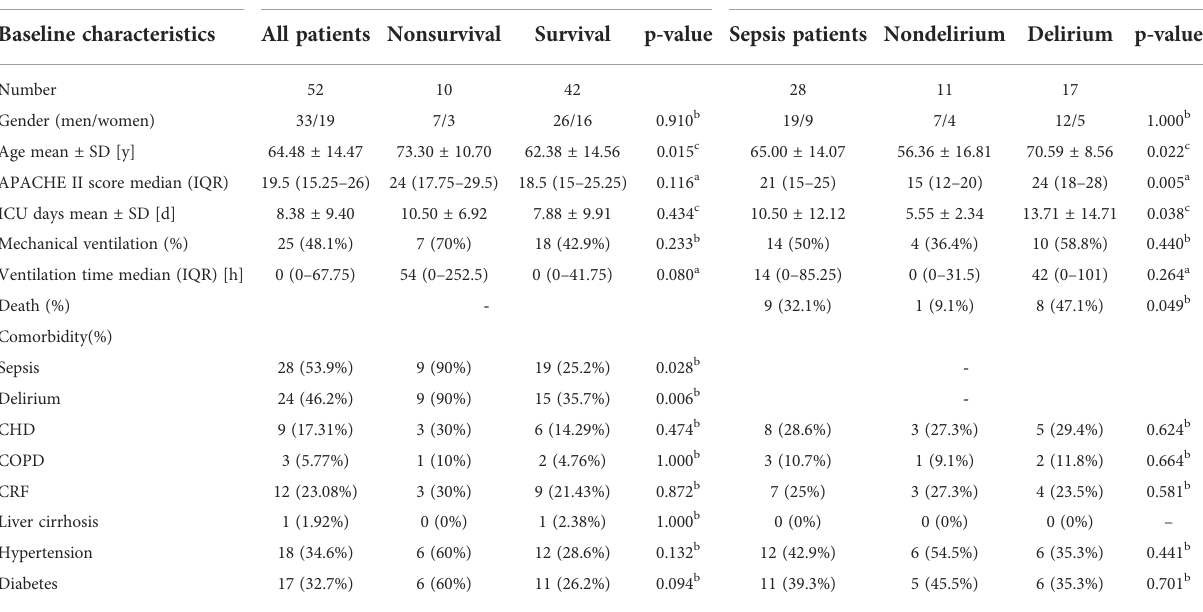
TABLE 1 Baseline characteristics of examinational cohort and subset cohort of